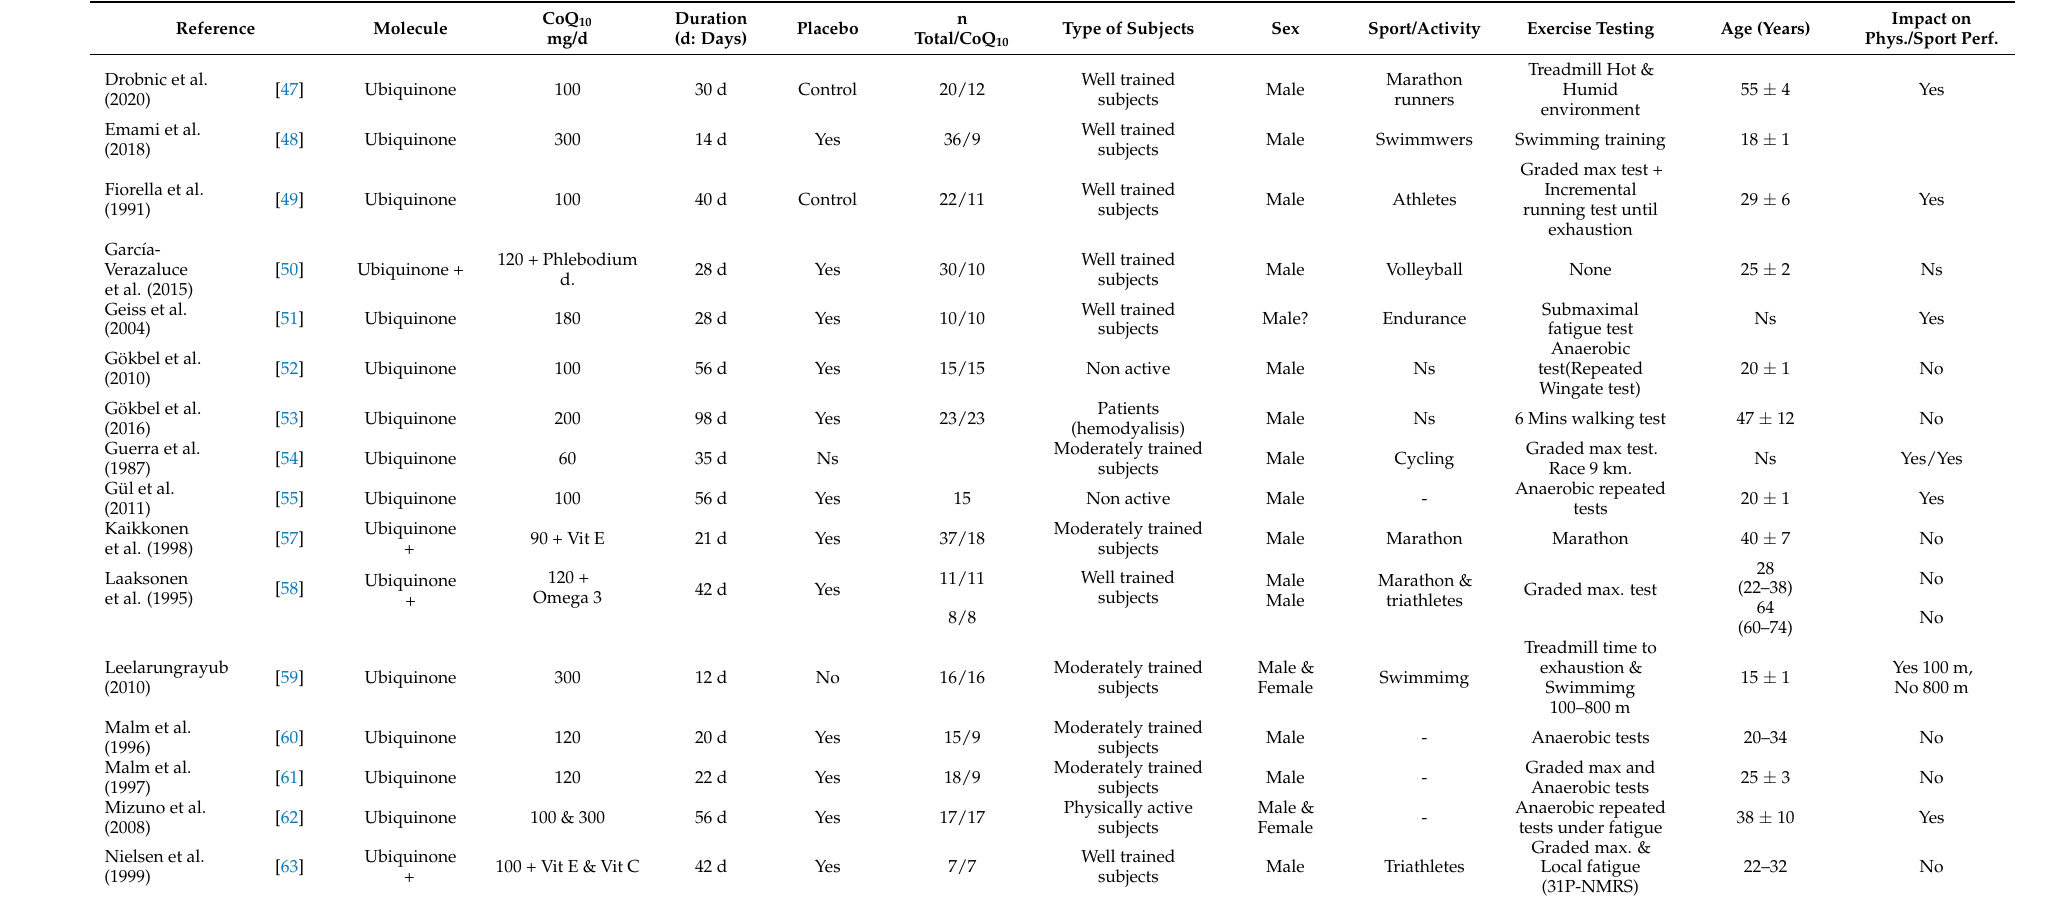
Table 6. Studies without the inclusion